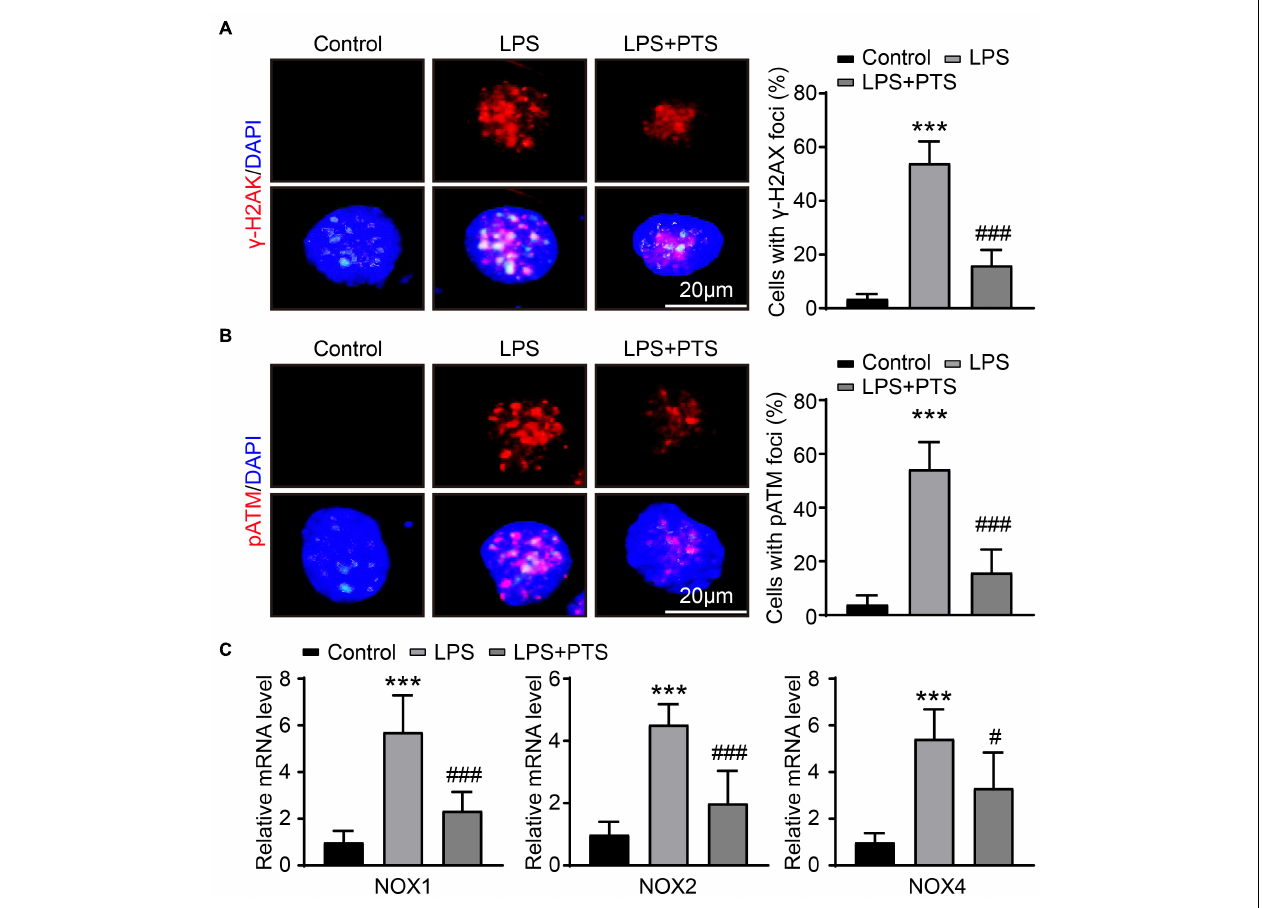
FIGURE 5 | PTS reduces oxidative stress in LPS-Induced H9C2 cells. (A) Representative of γ -H2AX and DAPI from control group, LPS group, and LPS + PTS group on the left and quantitative data are shown on the right ( n = 6). (B) Representative of p-ATM and DAPI from control group, LPS group, and LPS + PTS group on the left and quantitative data are shown on the right ( n = 6). (C) The mRNA levels of NOX1, NOX2, and NOX4 in heart tissue from control group, LPS group, and LPS + PTS group were detected by qPCR ( n = 6). *** P < 0.001 control vs. LPS, # P < 0.05, ### P < 0.001 LPS vs. LPS +